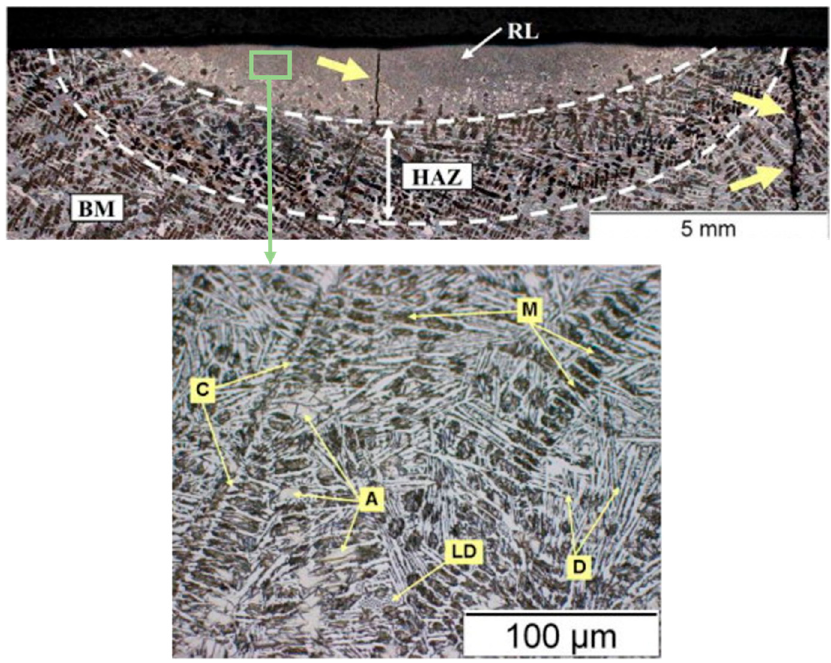
Figure 8. Microstructure of LSM ductile iron, formed by a parabolic remelted layer (RL), a heat- affected zone (HAZ), and the base material (BM), with visible cracks indicated by arrows ( top ); magnification of RL microstructure ( bottom ) (Reprinted with permission from ref. [51]. 2012 Else- vier).